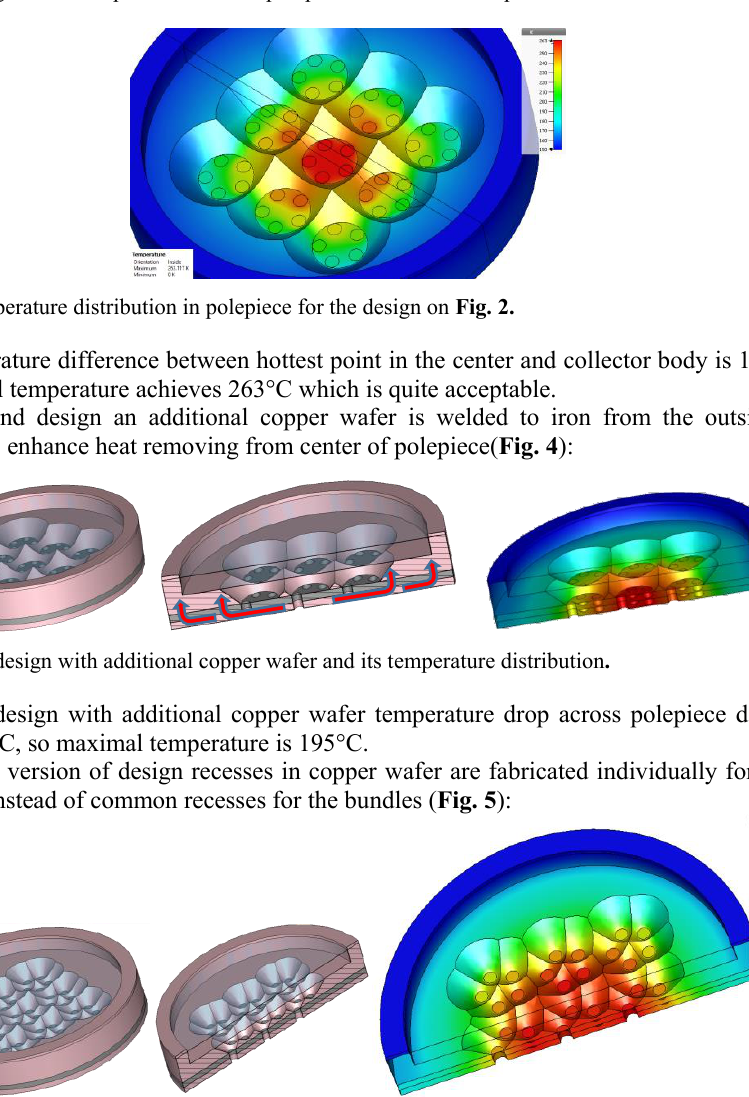
Fig. 2. Design of central part of dissected polepiece in multibeam depressed collector .